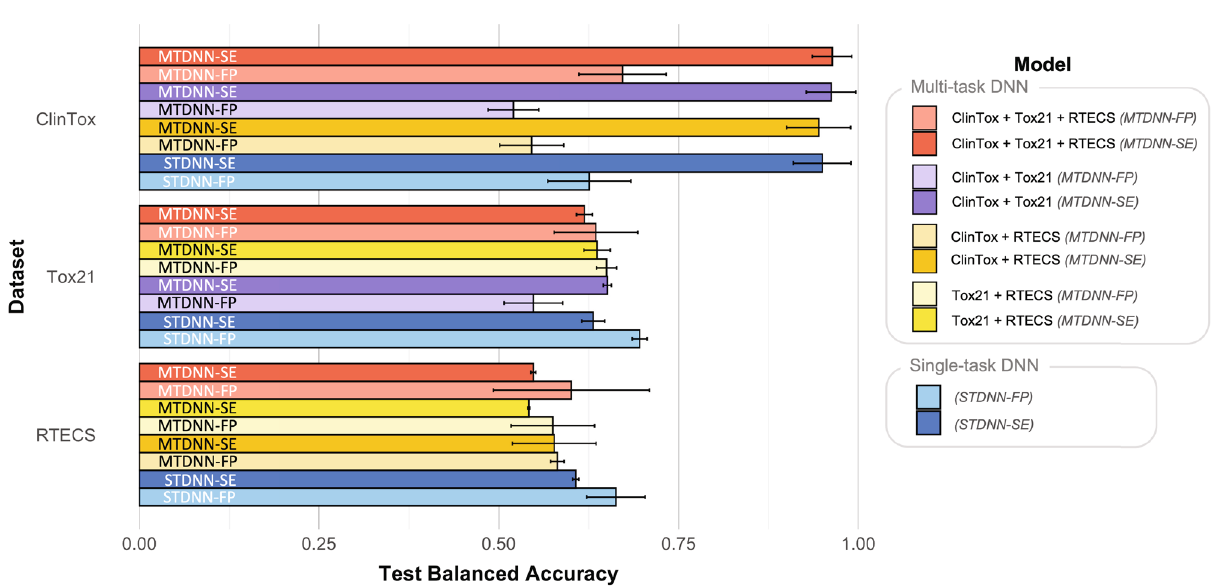
Figure 3. Average balanced accuracy on the test set for ClinTox, Tox21 and, RTECS predictions, comparing multi-task models to single-task models, with SMILES embeddings and Morgan fingerprints as